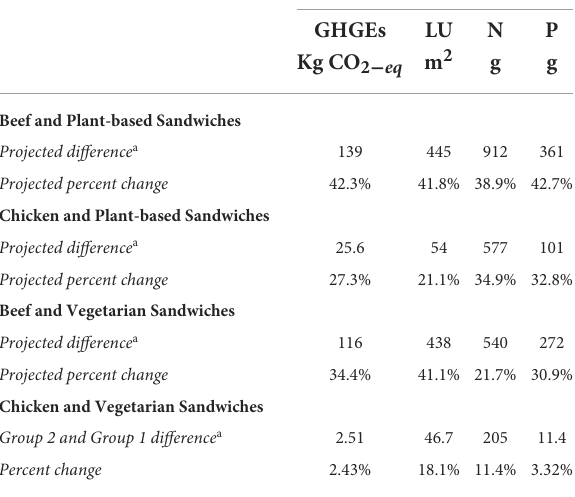
TABLE 6 Projected improvement in hypothetical planetary boundary impacts when using a vegetarian or plant-based default meal vs. a meat default